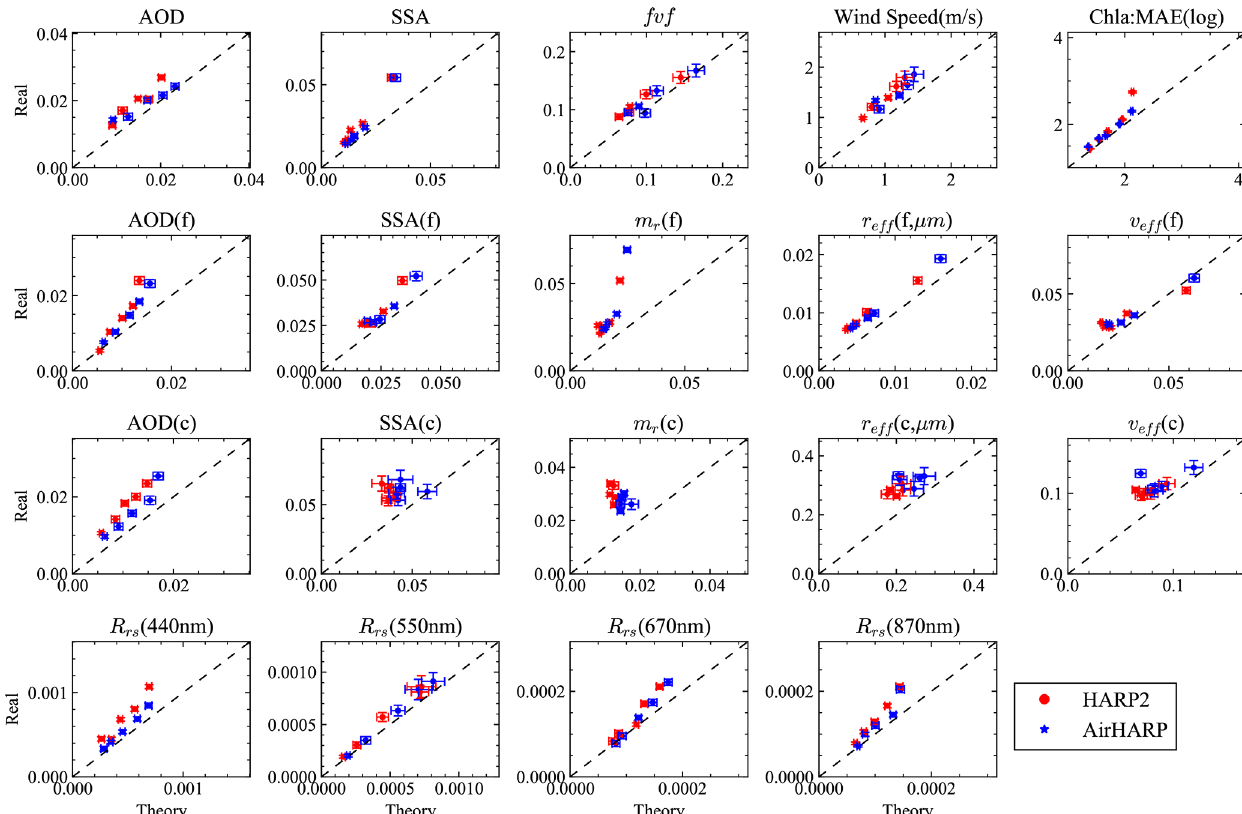
Figure 8. Comparing the averaged MAE derived from theoretical and real uncertainties for both HARP2 and AirHARP. The error bars indicate the 1 σ uncertainties of the MAE based on the average of 10 sets of random theoretical errors as discussed in MCEP method in Sect. 3.2. The same error bar is used for the real uncertainties as an approximation.